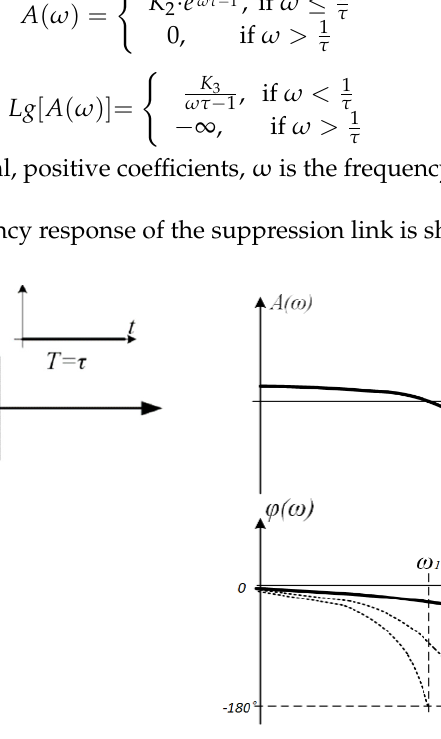
Figure 2. Logarithmic amplitude − frequency characteristics of the suppression link.